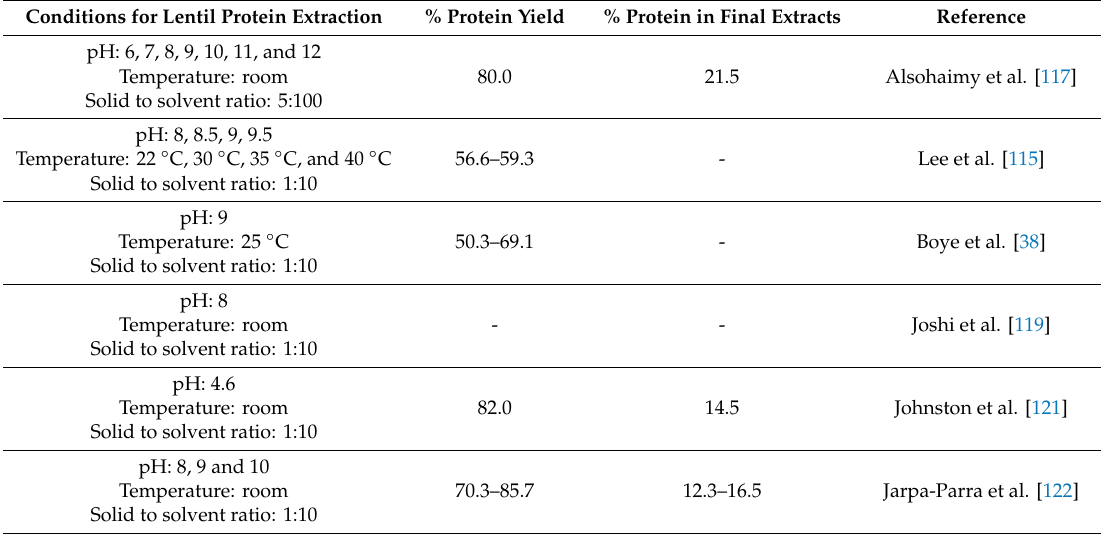
Table 5. Conditions for wet fractionation methods for extraction of lentil protein in six recent studies. Conditions for Lentil Protein Extraction % Protein